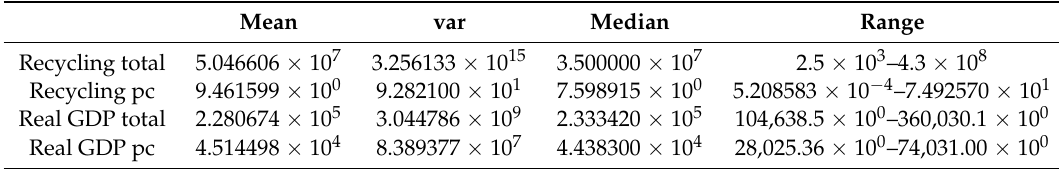
Table A2. Descriptive Statistics of the data for Middle Rich States.